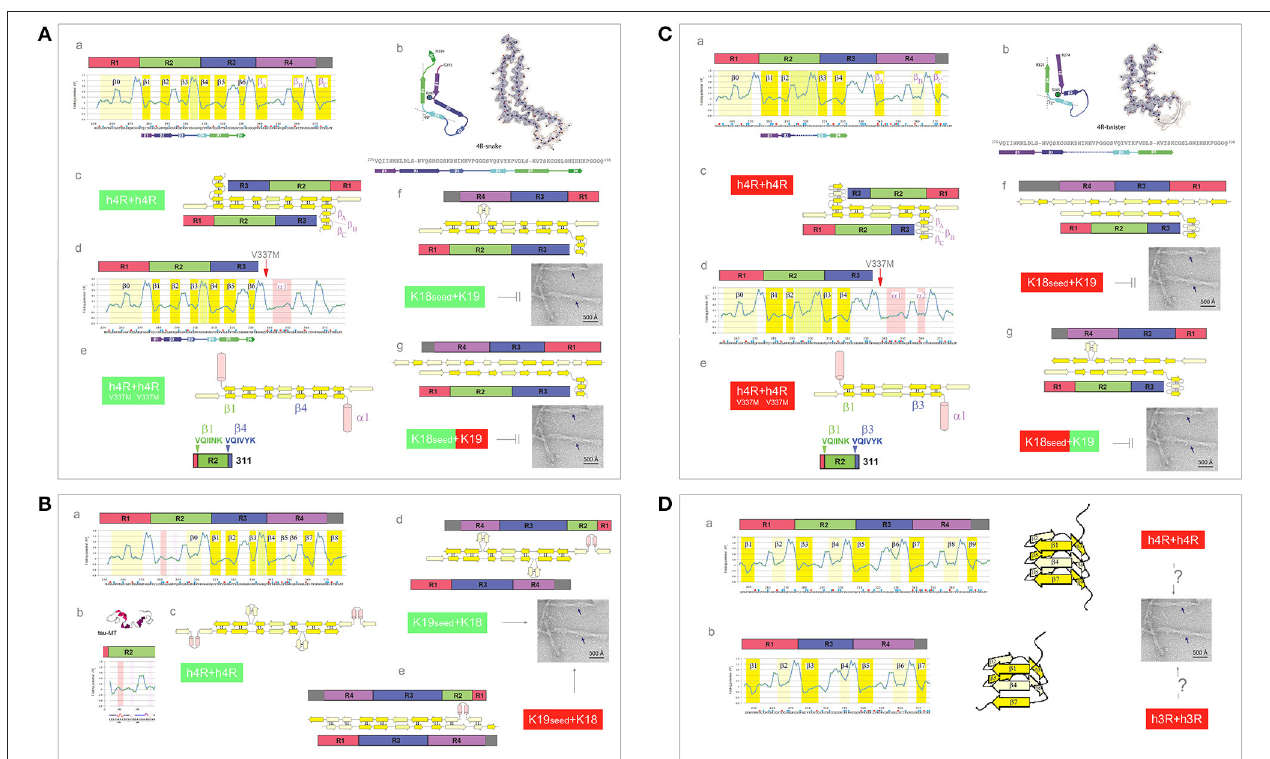
FIGURE 8 | Electronic configuration of the polypeptide backbone and divergent pathways of fibrillization of 4R isoforms: heterogeneity of the heparin-induced tau fibrils and asymmetric cross-seeding barriers. (A) (a) The FP i profile of the tau repeat domain 4R (R1R2R3R4) calculated with σ His = − 0.2917. The FP i assignment of the secondary-structure propensity is compared to the strand assignment in the 4R-snake fold of tau fibrils, see the color-coded bar immediately below the FP i plot; (b) The diagram of the 4R-snake fold, taken from Zhang et al. (2018); (c) The corresponding model of the staggered antiparallel homodimer 4R ↑ 4R ↓ ; (d) The FP i profile of the repeat domain 4R (R1R2R3R4) of the tau V337M. Note the change of the propensity of R4 into “helix”; (e) The corresponding model of the antiparallel homodimer 4R ↑ 4R ↓ with R4 folded into “helix”; (f) The model of the antiparallel “non-protonated” heterodimer 4R ↑ 3R ↓ , notice the lack of 2-fold symmetry. The model implies that the K18 seeds cannot template oligomerization of K19 under these conditions; (g) The model of the antiparallel 3R( + ) ↓ 4R ↑ heterodimer, notice the lack of 2-fold symmetry. The model implies that K18 seeds cannot template oligomerization of K19 under these conditions either. (B) (a) The FP i profile of the tau repeat domain 4R (R1R2R3R4) calculated with σ His + = 0.2584 for H299, and selectively induced into “helix” in R2; (b) The FP i profile of R2 bound to microtubule as a “helix” bundle, PDB ID 2mz7; (c) The corresponding model of the staggered antiparallel homodimer 4R ↑ 4R ↓ ; (d) The model of the alternative “non-protonated” 3R ↑ 4R